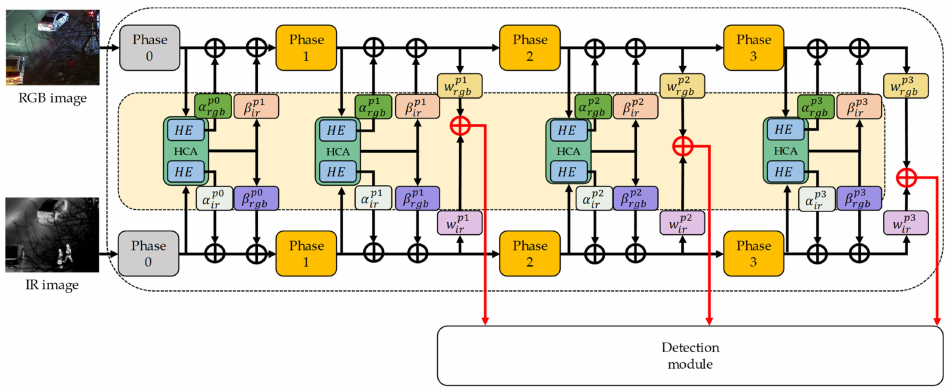
Figure 7. Overall architecture of the proposed